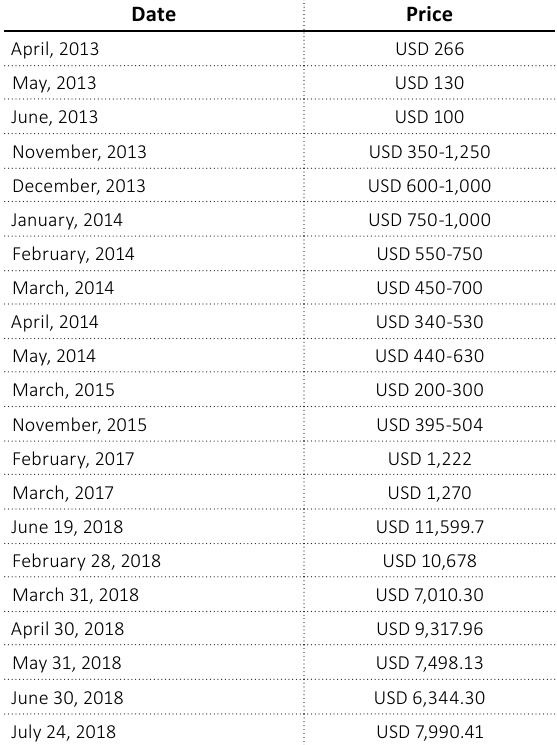
Table 2. Historical price of Bitcoin